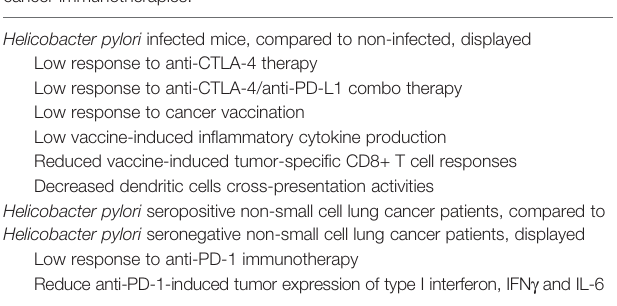
TABLE 2 | Helicobacter pylori infection reduces the ef fi cacy of cancer immunotherapies. Helicobacter pylori infected mice, compared to non-infected, displayed Low response to anti-CTLA-4